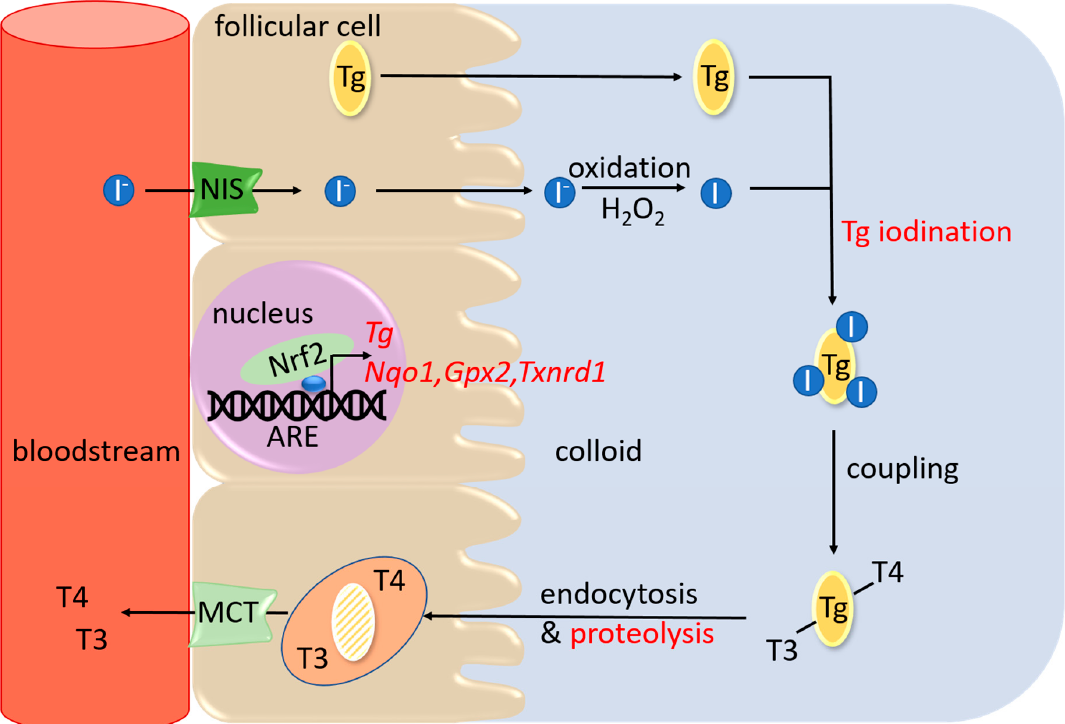
Figure 1. Schematic simplified representation of thyroid hormone synthesis. Iodide (I − ) enters thyroid follicular cells by active transport via the sodium (Na + )-iodide symporter (NIS), and is then exported via other channels into the follicular lumen (the colloid area), where it is oxidized to iodine (I) and used in the iodination of thyroglobulin (Tg). Coupling between di- and/or mono-iodinated tyrosines of Tg produces the thyroid hormones T4 and T3, attached to the Tg backbone. Tg is then endocytosed into the thyroid follicular cells, where it is degraded inside lysosomes, ultimately releasing T4 and T3 into the blood circulation via a monocarboxylate transporter (MCT). Steps affected by Keap1/Nrf2 signaling are highlighted in red font. They include: (i) a positive effect on the transcription of the gene encoding Tg; (ii) a positive effect on the transcription of antioxidant and selenoprotein genes such as Nqo1 (NAD(P)H quinone dehydrogenase 1), Gpx2 (glutathione peroxidase 2), and Txnrd1 (thioredoxin reductase 1); a negative effect on Tg iodination; (iv) a positive effect on Tg proteolysis.